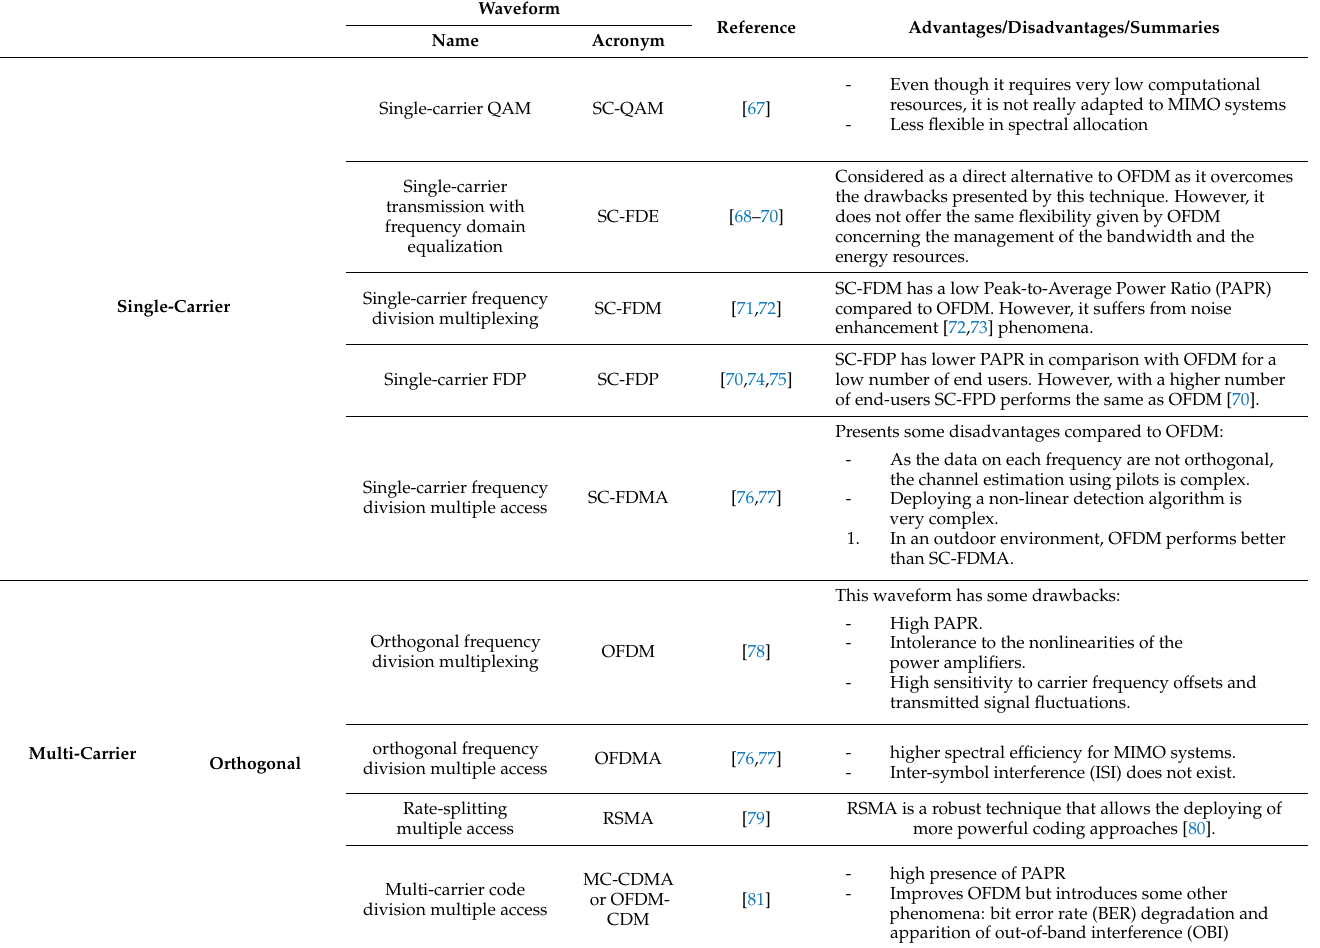
Table 3. MIMO waveforms classification: single-carrier and multi-carrier spectrum access